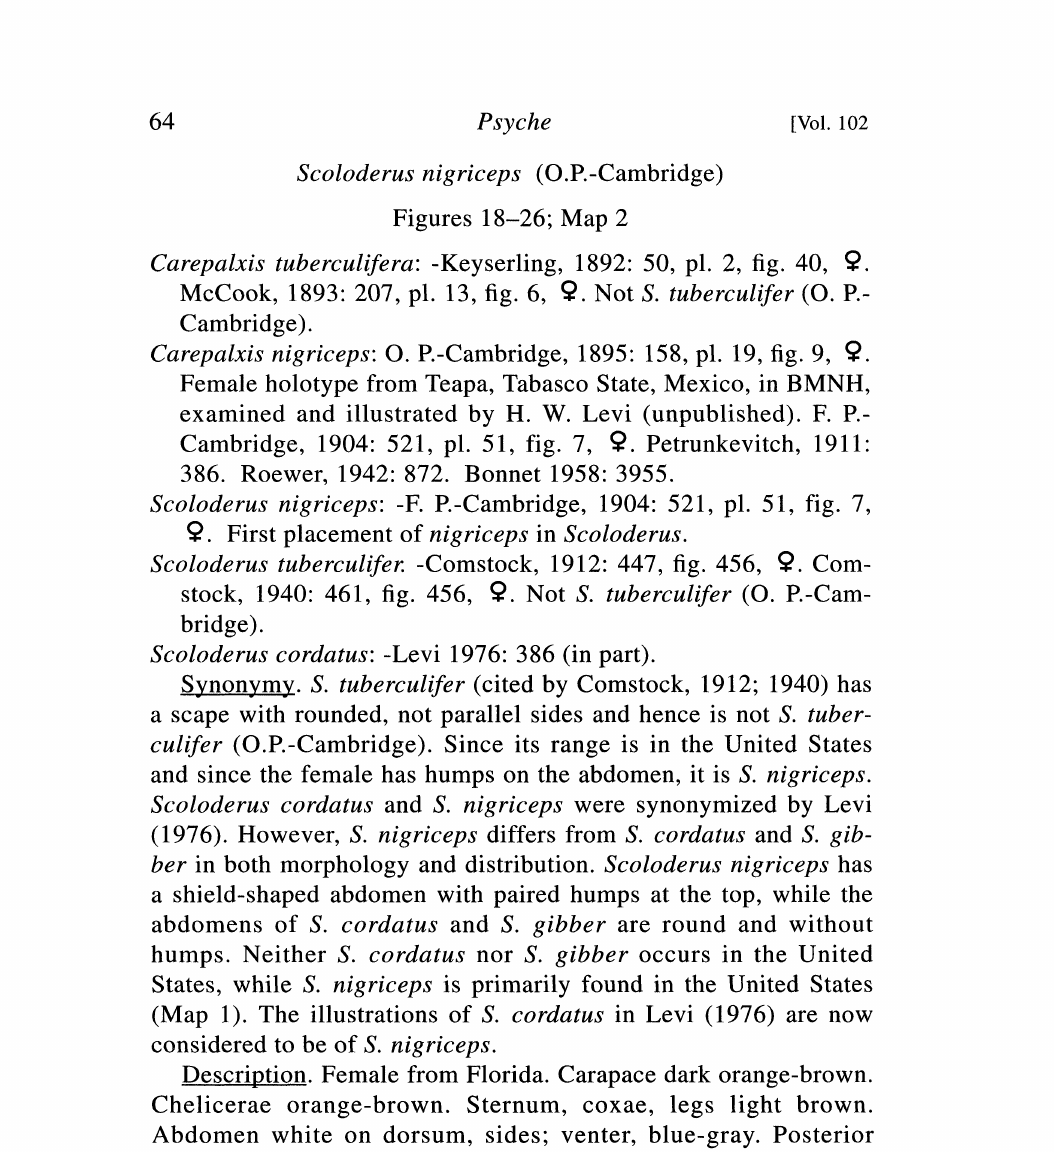
eral eyes. Clypeus height 2.0 AME. Carapace hump without notch rior and two on shoulders (Figs. 19, 20). Total length 3.5 mm. Carapace 1.6 mm long, 1.4 wide, and 1.1 high. Sternum